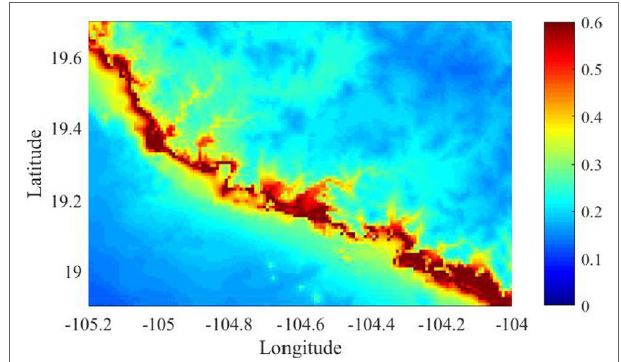
FigUre 10 | Spatial distribution of h − 1/4 around target area (the areas correspond Figure 4B